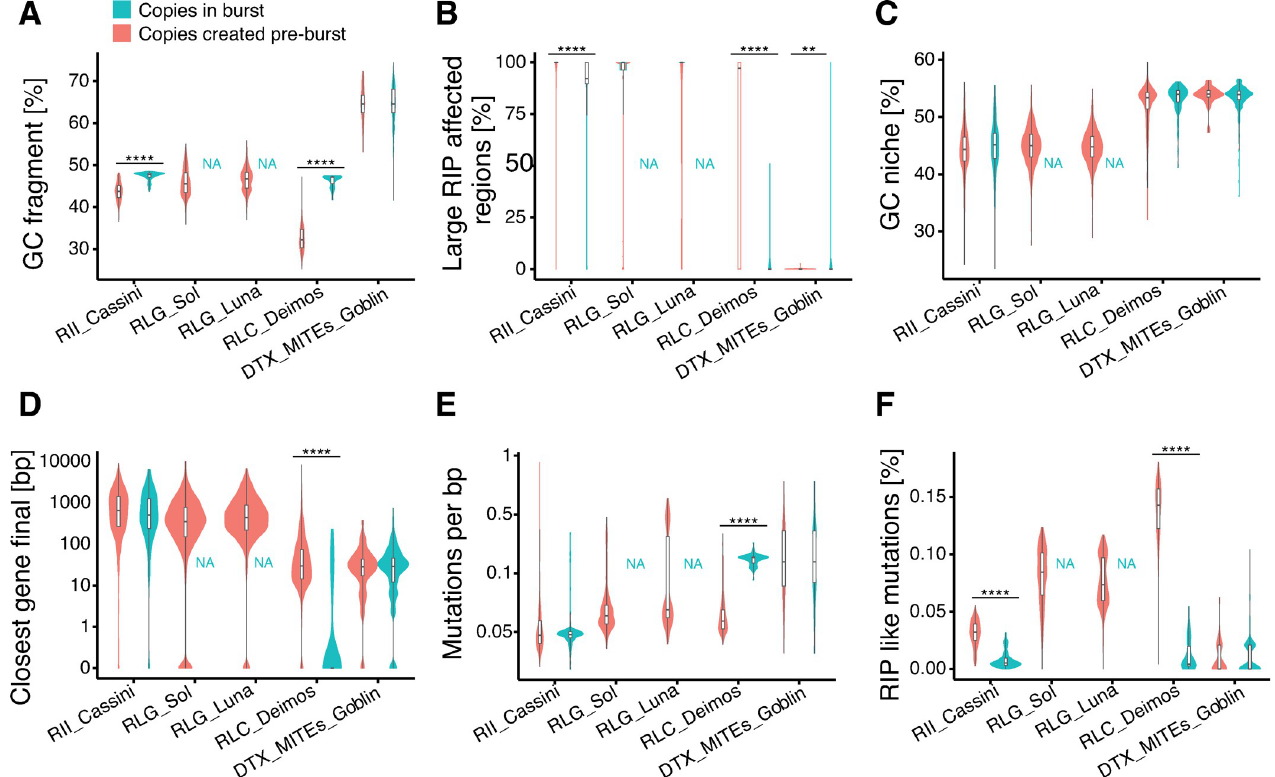
Fig 6. High copy number TE families and characteristics of burst initiation: Comparison of copies in bursts (red) and all other copies (blue) for the five TE families with the highest copy numbers. The TE families RLG_Luna and RLG_Sol have no copies assigned to burst clades (indicated by NA). The mutation rate was corrected for the length of the fragment and the number of copies across